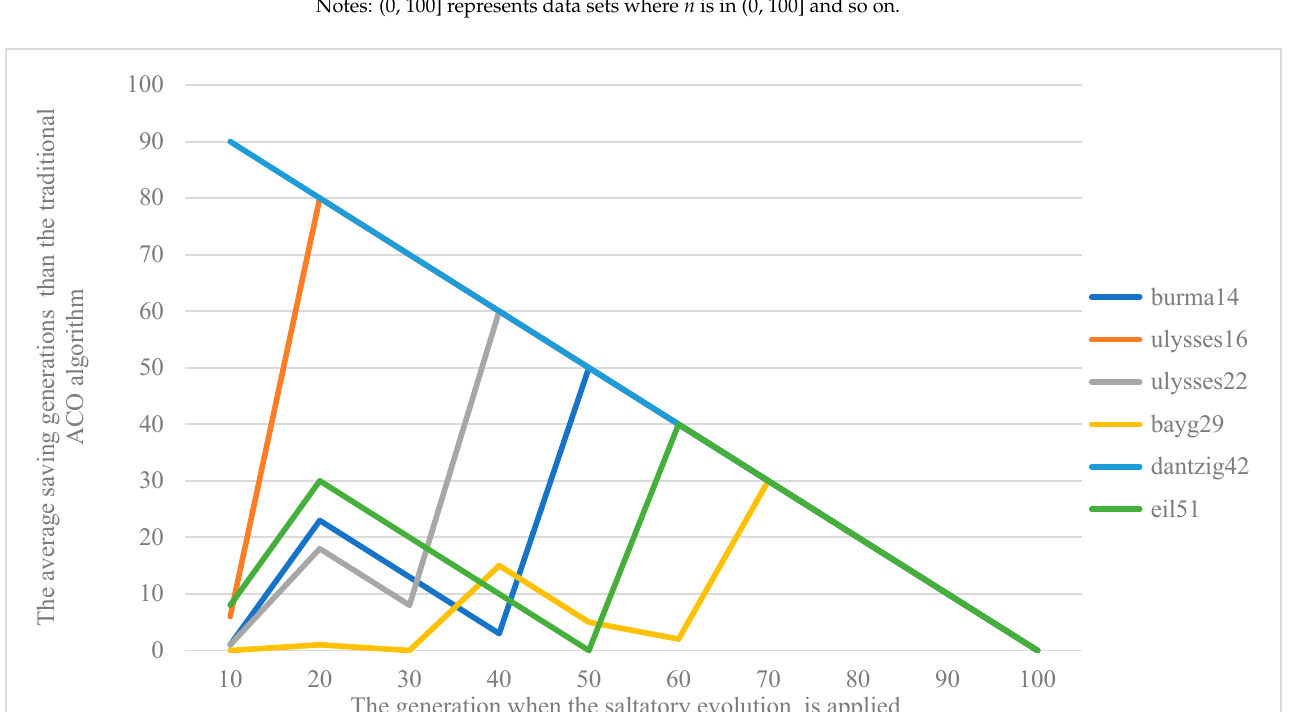
Table 5. The average saving generations of SEACO algorithm than ACO algorithm on all data sets.